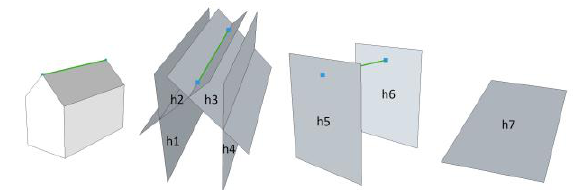
Figure 2. Saddleback roof defined by seven planar